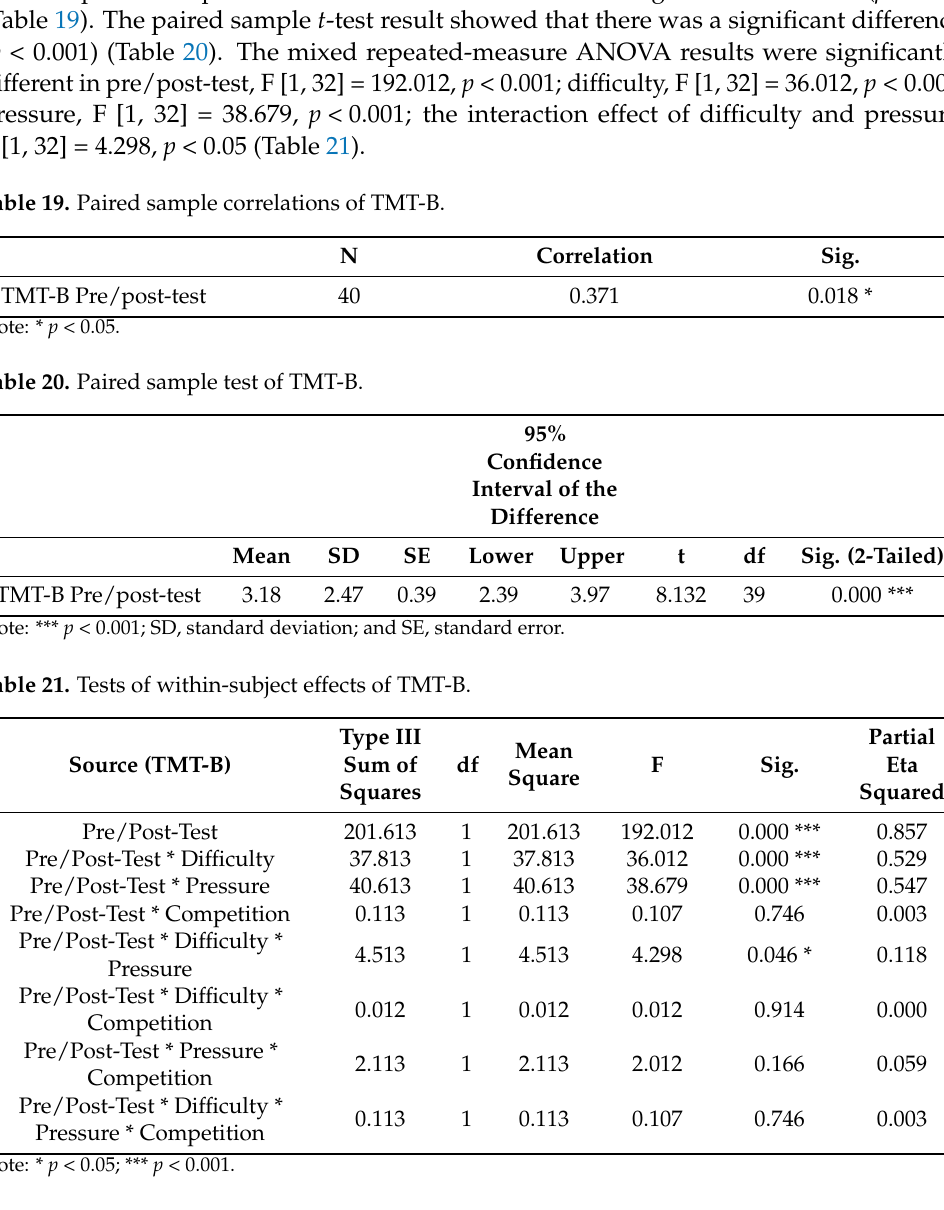
Table 18. Paired samples statistics of TMT-B. Mean N SD SE TMT-B Pre-test